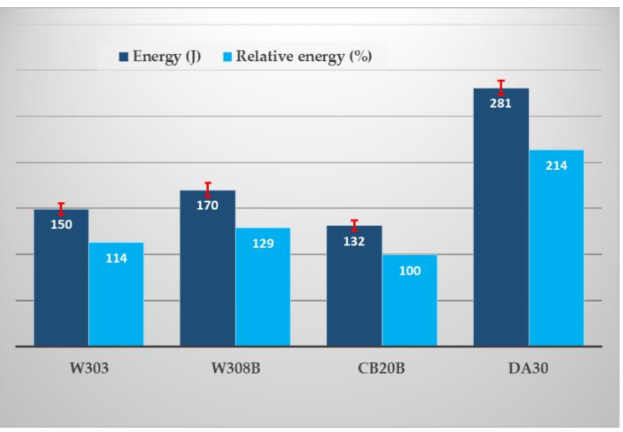
Figure 8. The collapsibility of studied binder